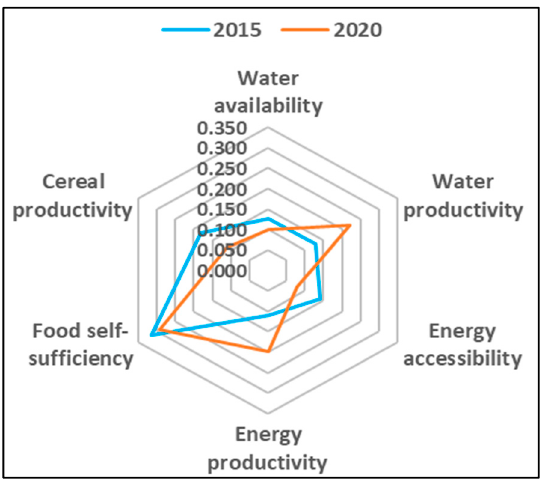
Figure 3. Changes in WEF nexus indicators between 2015 and 2018. The comparison is necessary to assess progress towards